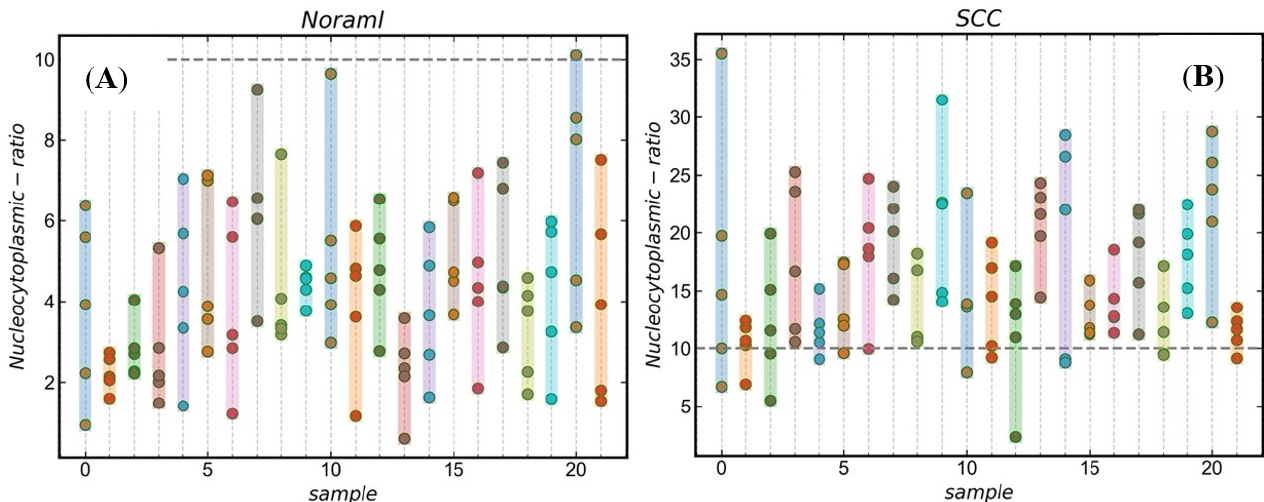
Figure 5. Distribution of the nucleoplasmic ratio of skin tissue cells. ( A ) Normal; ( B ) cSCC.